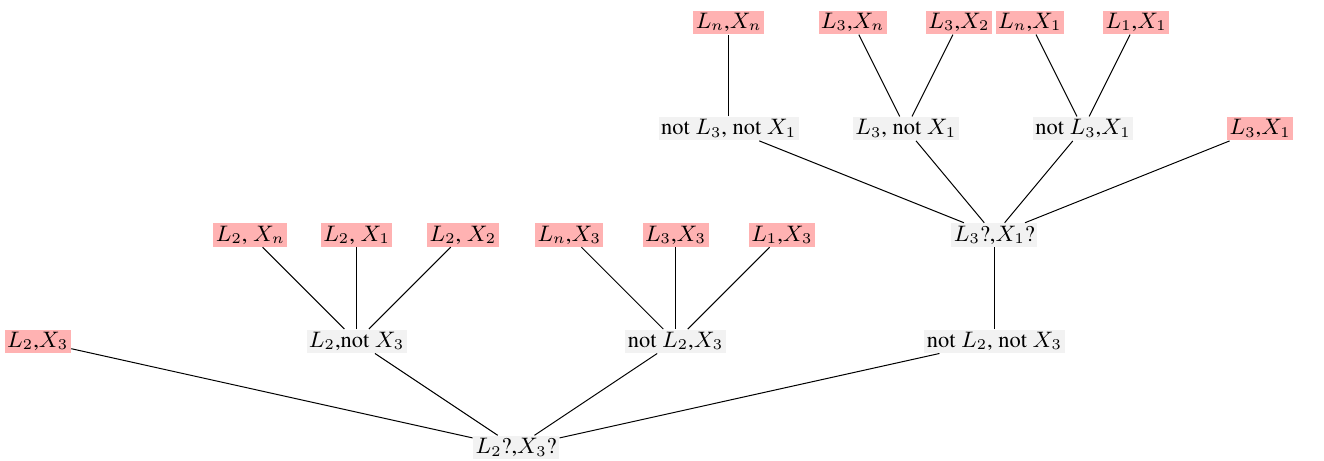
Table 8: Calculation of the border numbers of all L and X .